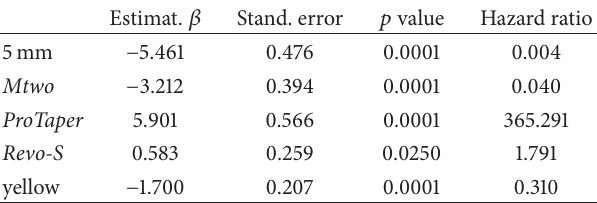
Table 2: Results of the Cox proportional hazard model of the cyclic fatigue lifetime of the instruments. The set of reference categories is 3 mm radius, Wizard Navigator , and red ISO